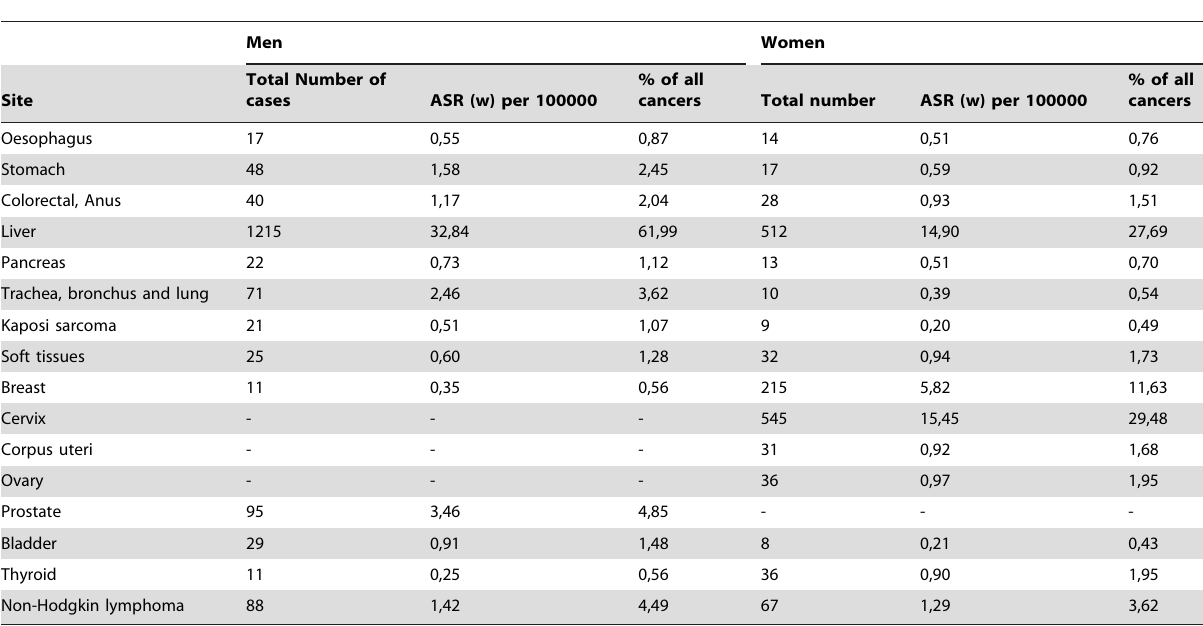
Table 1. Most common cancers in The Gambia for the period